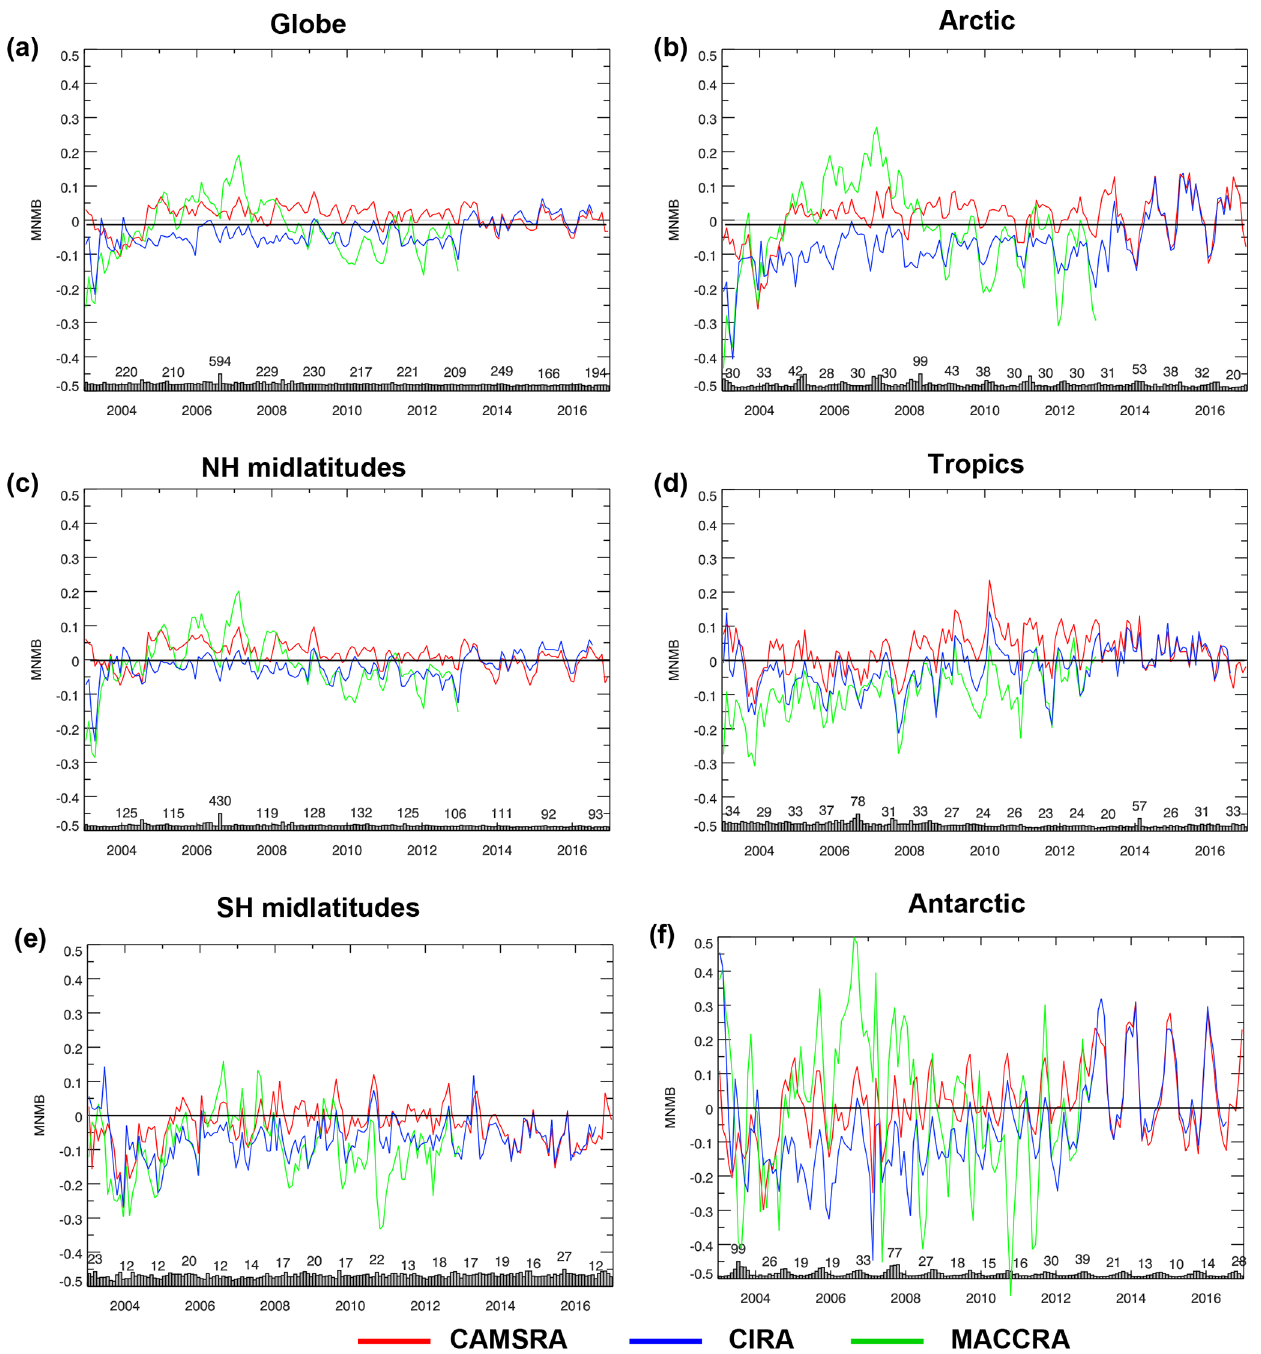
Figure 10. Time series of the modified normalised mean bias (MNMB) in the free troposphere (750–300hPa) of the reanalyses versus ozone- sondes for (a) global mean, (b) Arctic, (c) NH midlatitudes, (d) tropics, (e) SH midlatitudes and (f) Antarctica. CAMSRA is in red, CIRA in blue and MACCRA in